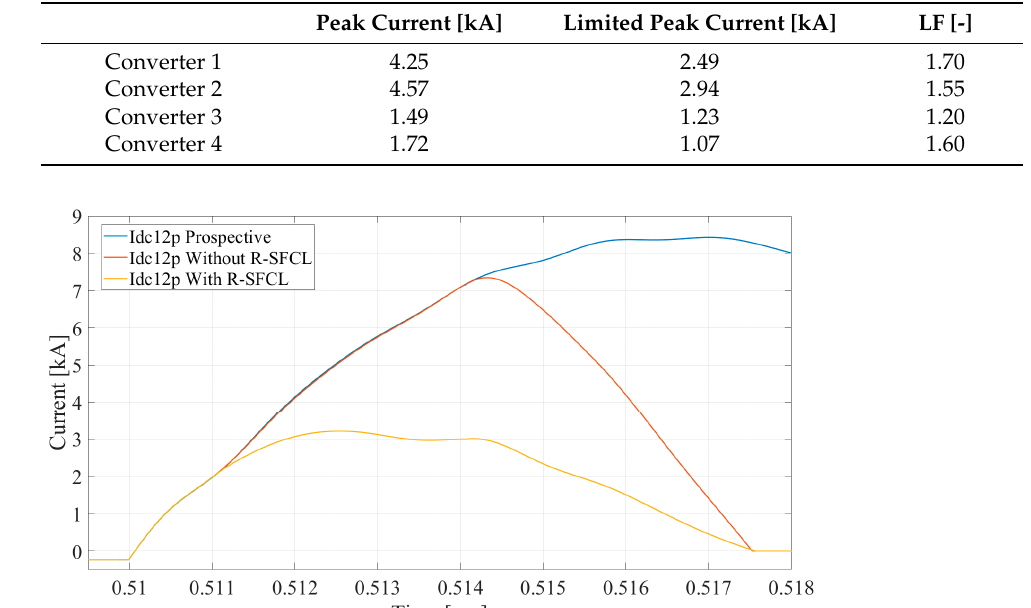
Figure 24. Link 12 positive pole fault current for pole-to-ground fault, prospective, with M-DCCB, with M-DCCB and R-SFCL.